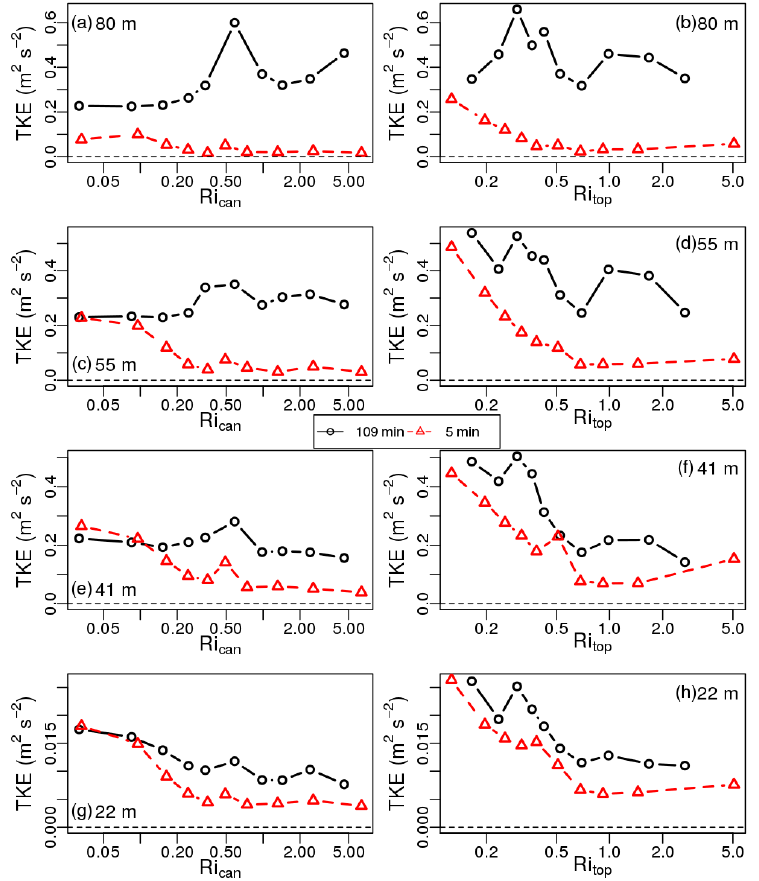
Figure 10. The dependence of TKE on canopy Richardson number (Ri can ; a , c , e , g ) and top Richardson number (Ri top ; b , d , f , h ) for all levels, as indicated in each panel, using 5min (red lines, triangles) and 109min (black lines, circles) time